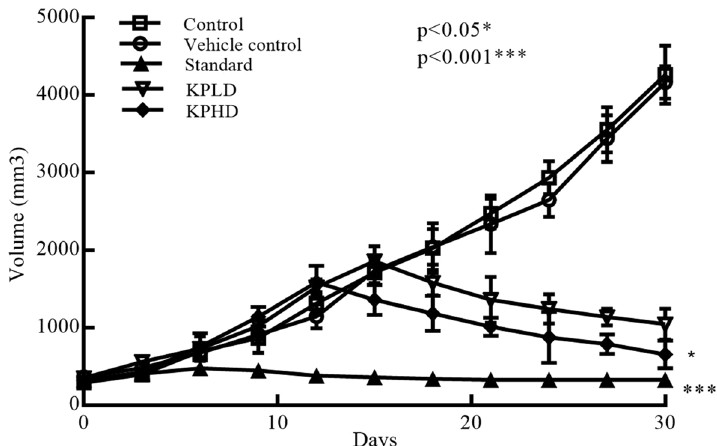
SD, n 5. One-way ANOVA was used to ± =